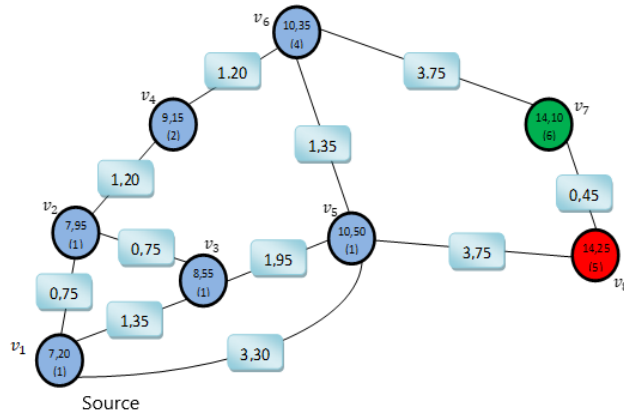
Figure 10. Finding the optimal path from peak 1—step 7.